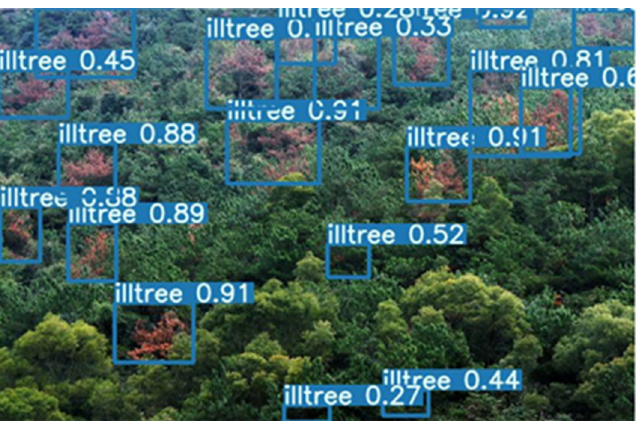
Figure 15. The figure of the detection effect of pine wilt nematode trees.